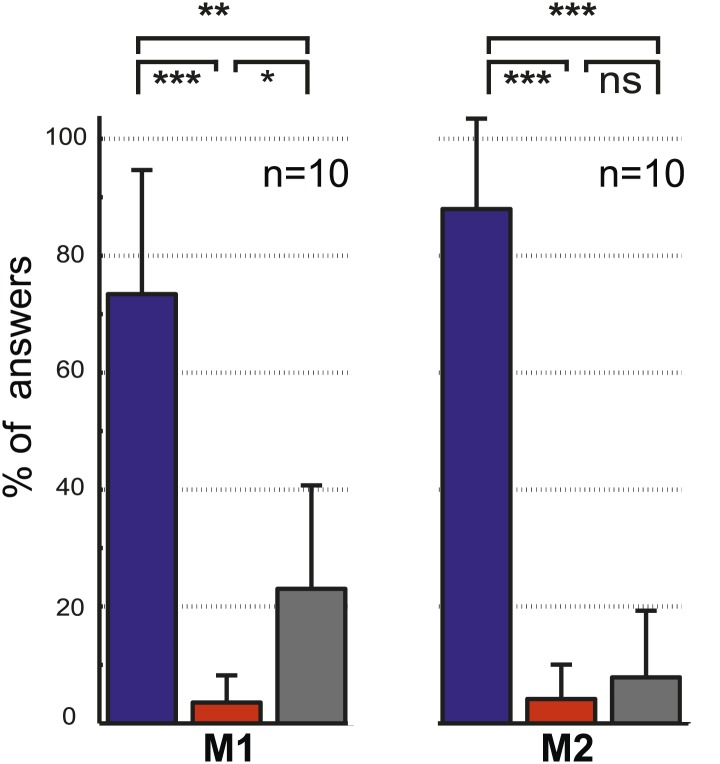
The results of the control experiment testing for associations between demonstrator's identity and target location (Figure 2—figure supplement 1).Mean percentages of responses classified as falling into the 'learned absolute spatial associations' category (blue column), the 'learned relative spatial associations' category (red column) and in the 'other' category (gray column). Both monkeys exhibited significantly more responses in the 'learned absolute spatial associations' category than in the two other categories (repeated measures 1-way ANOVA, significant effect of the factor 'response category' [F2,18 = 30.6, p<0.001 (M1); F2,18 = 104.2; p<0.001 (M2)]; post hoc pairwise comparisons [with Bonferroni correction] are presented on the graph with their significance levels: ***p<0.001, **p<0.01, *p<0.05, not significant [ns]; n indicates the number of experimental repetitions). Error bars represent standard errors.